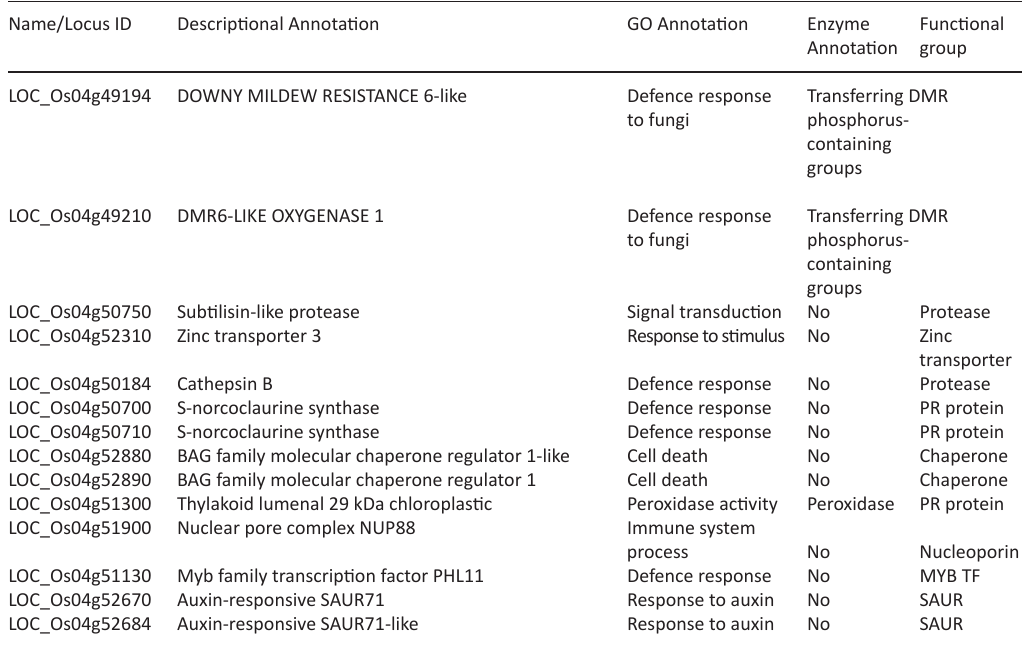
Table 3. List of defence related genes in qBFR4 with descriptional and GO annotation Name/Locus ID Descriptional